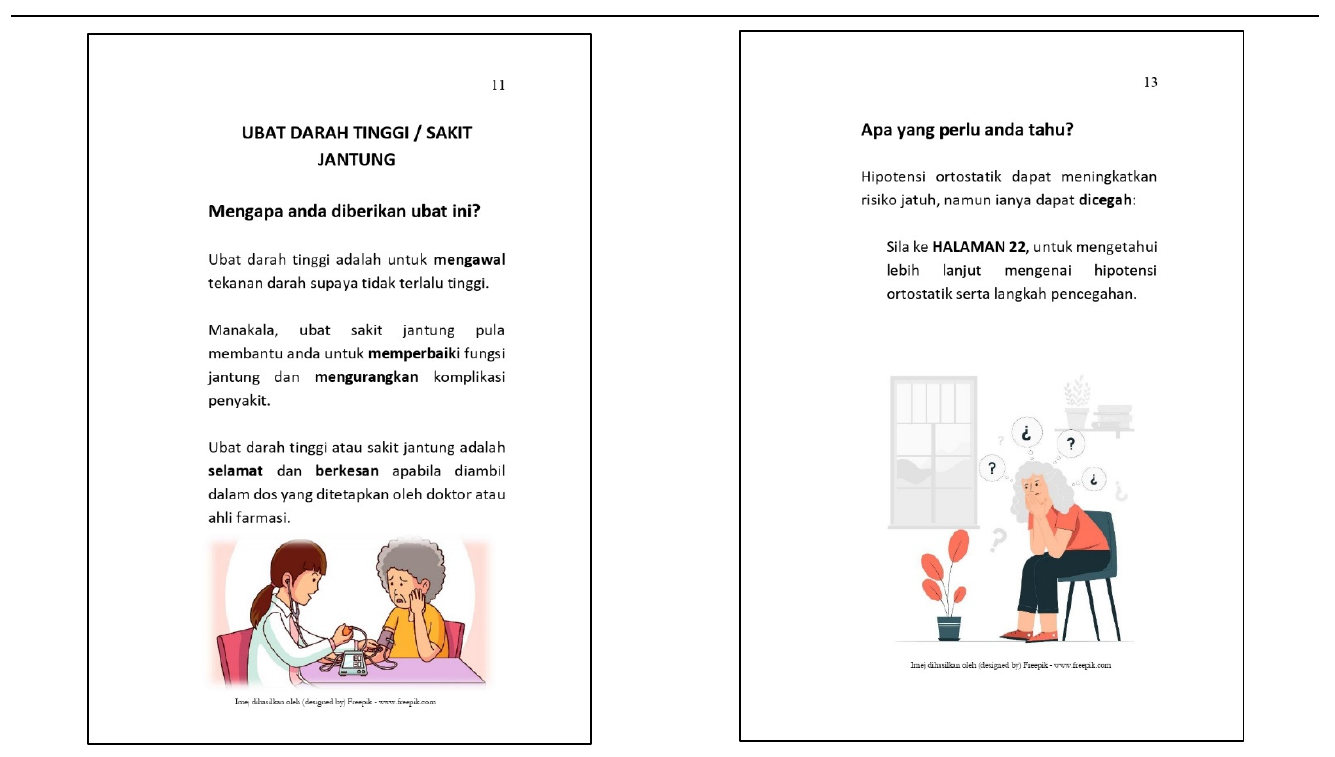
Table A4. Sample pages of the